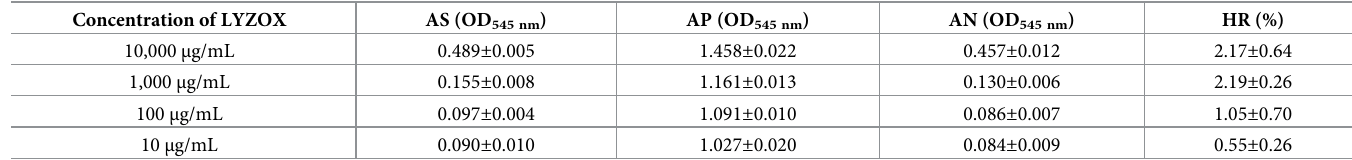
Table 2. Hemolytic toxicity test.